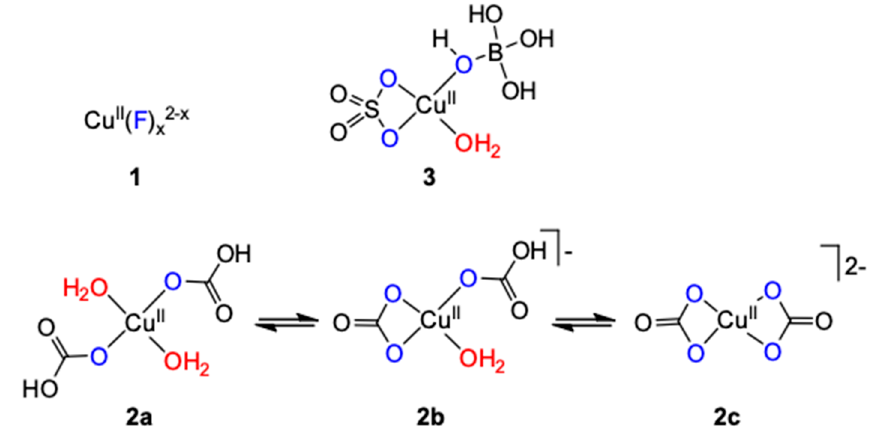
Figure 2. Cu-based molecular WOCs with inorganic ligands.